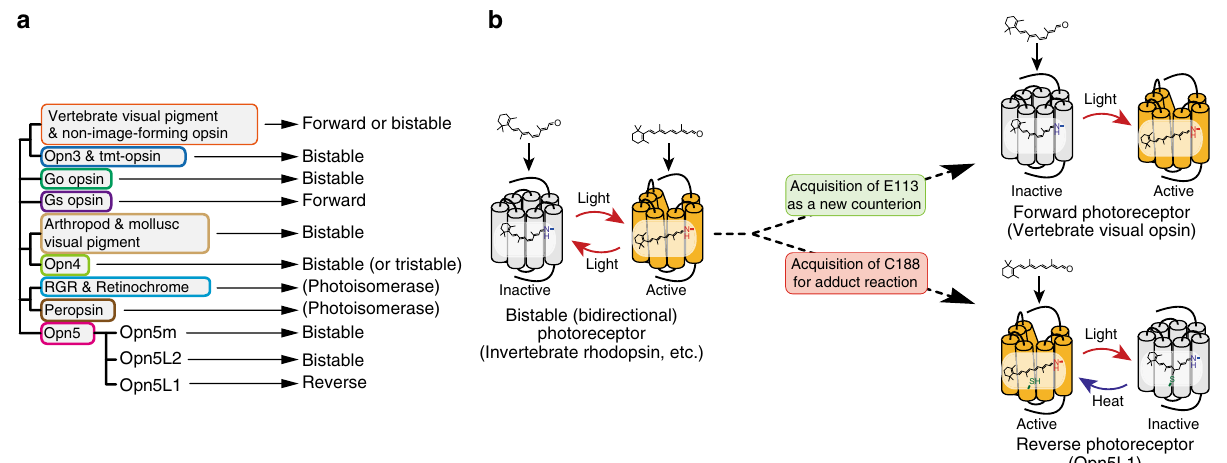
Fig. 7 A possible scenario of evolution of forward and reverse photoreceptors from an ancestral bistable opsin. a Phylogenetic view of opsin family and photochemical properties of the groups in the family. As many members in most of the groups show the bistable nature, such bistability should be an ancestral type of the photochemistry of opsins. b Schematic view of possible evolutionary branching into forward and reverse photoreceptors. Loss of ability to directly bind all- trans -retinal and undergo its trans - cis photoisomerization produced forward photoreceptors. On the other hand, reverse photoreceptors lost the ability to bind 11- cis -retinal along with the ability to undergo the photo-conversion reaction from the inactive state to active